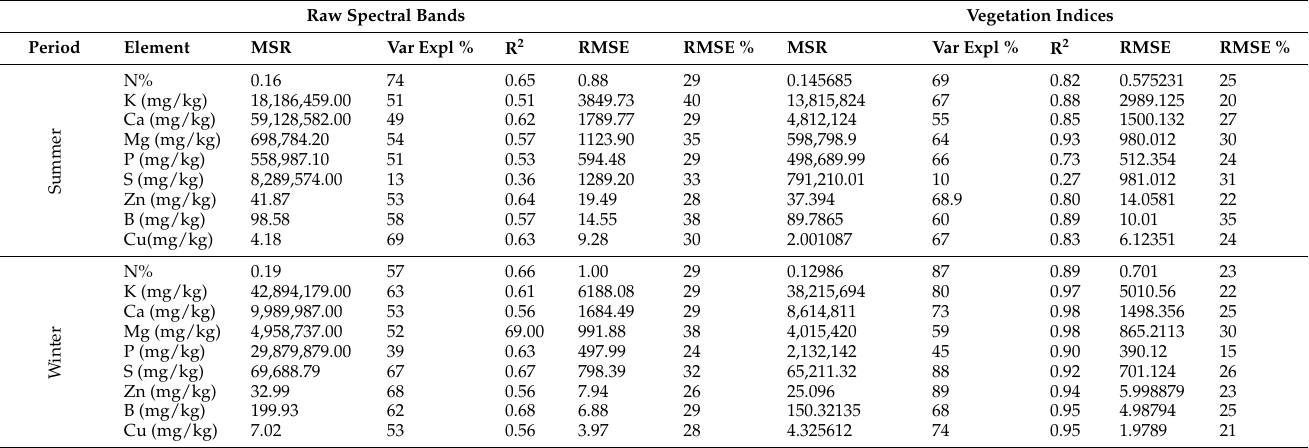
Table 5. Dry and wet season nutrient concentration variations accuracies for wetland vegetation. Raw Spectral Bands